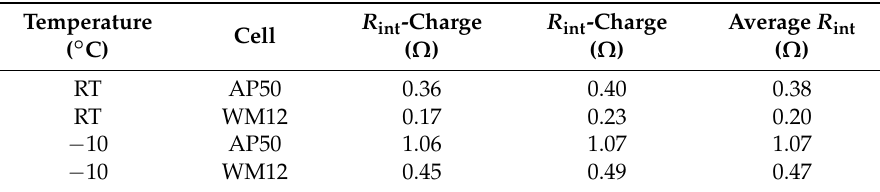
Table 6. Charge and discharge internal resistances ( R int ) at 60% SOC of Cells AP50 and WM12 measured at room temperature (RT) and − 10 ◦ C.